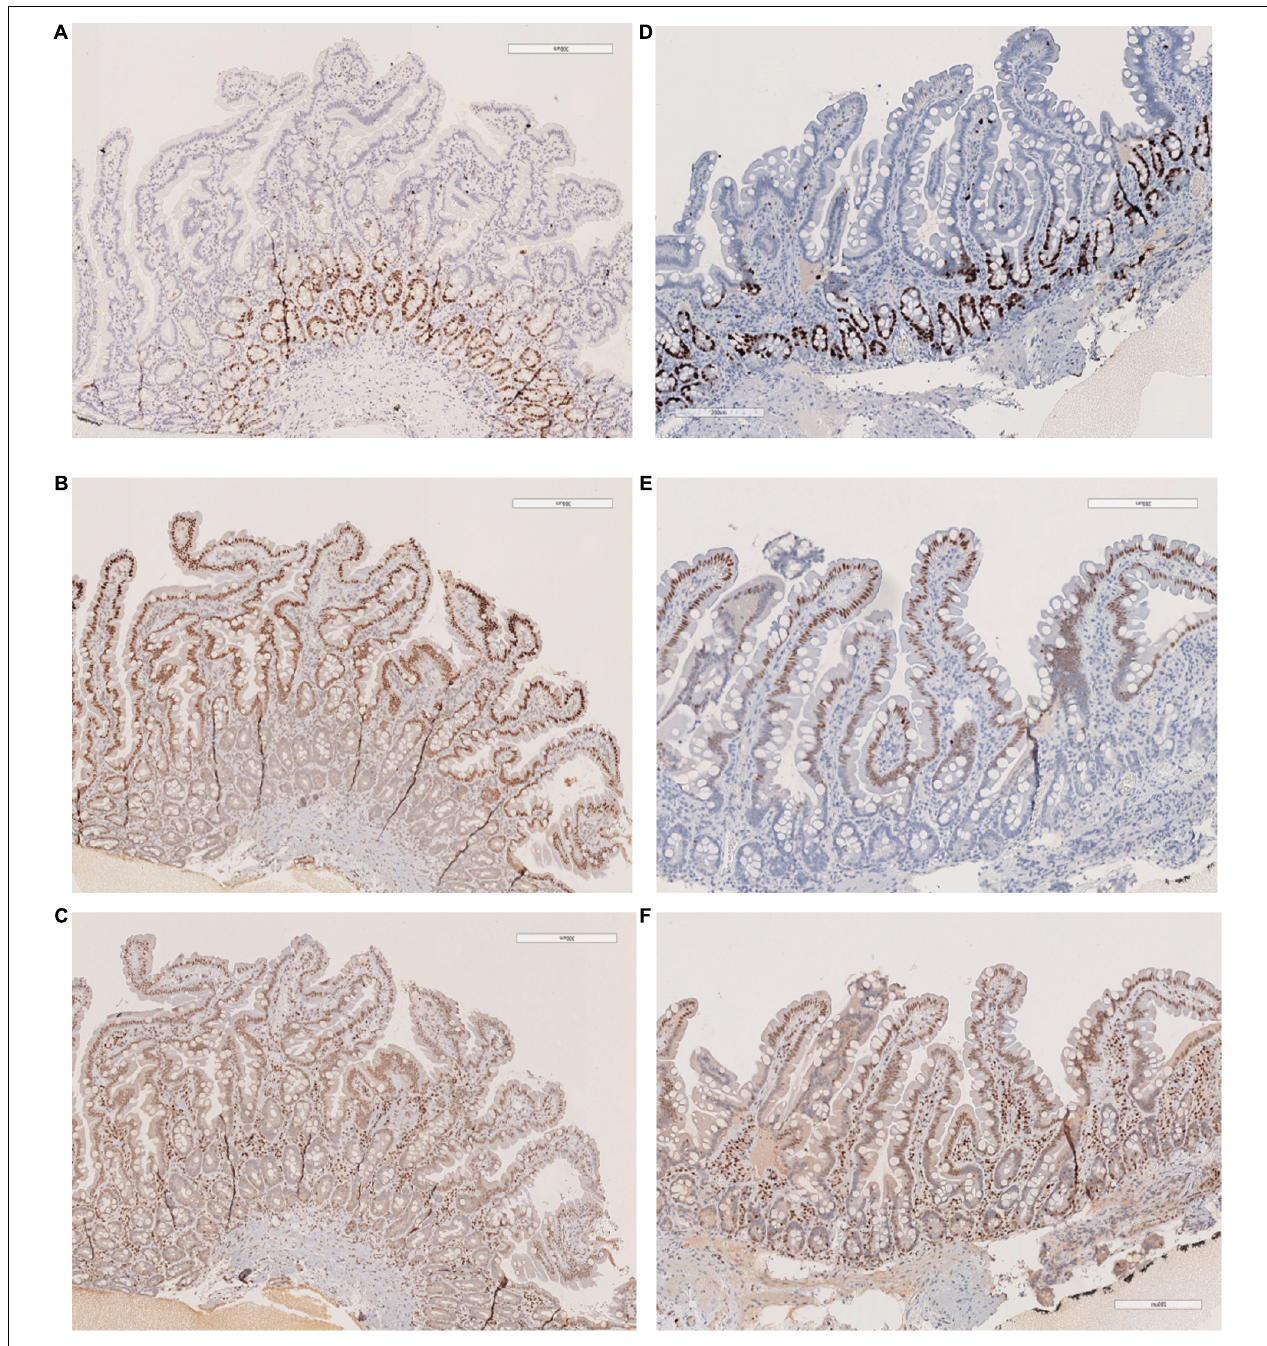
FIGURE 3 | Duodenal mucosa: (A) KI67, (B) p21, (C) p27, Control case (D) KI67, (E) p21, (F) p27.